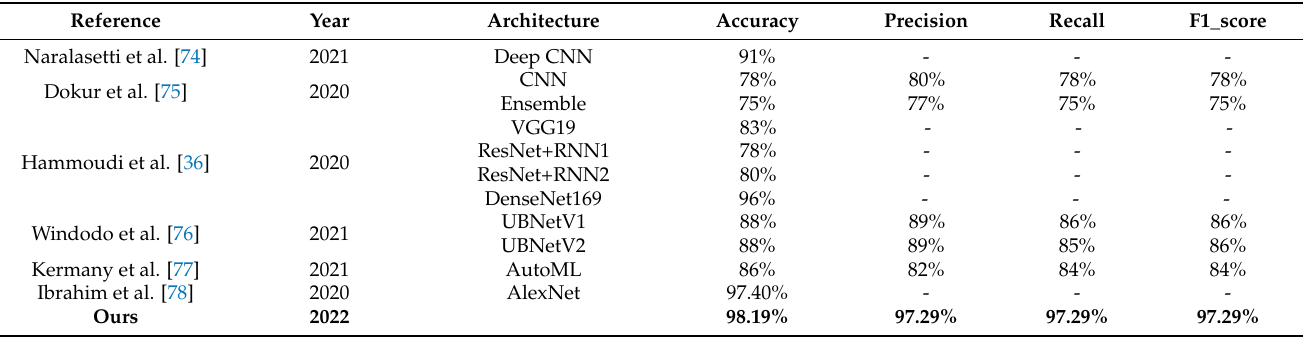
Table 12. Proposed model classification performance comparison with state-of-the-art models using